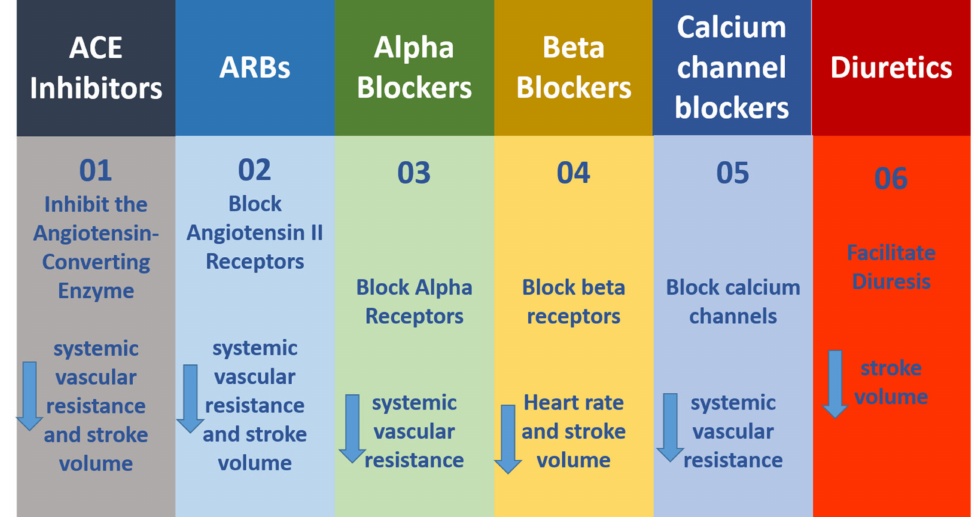
Figure 2. Seven classes of antihypertensive agents and their mechanisms of action. (01) ACE inhibitors; (02) Block Angiotensin II Receptors; (03) Alpha Blockers; (04) Beta Blockers; (05) Calcium channel blockers; (06)